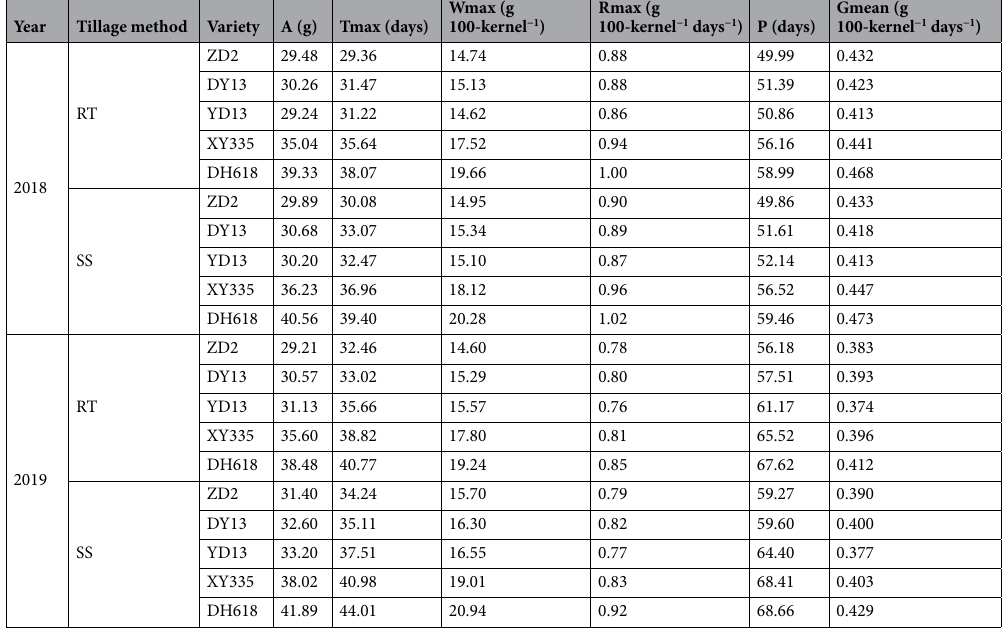
Table 3. Response of the grain filling characteristic parameters of maize varieties from different eras to tillage methods. Tmax is the time when the maximum grouting rate was reached; Wmax is the grain growth at the maximum filling rate; Rmax is the maximum grouting rate; P is the active grouting stage; Gmean is the average grouting rate; A is the ultimate growth rate of the grain.